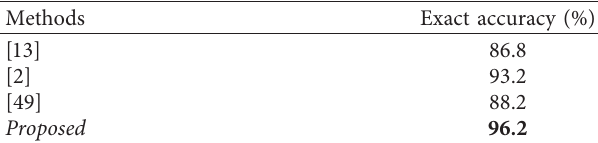
Table 5: Gender classification: performance comparison of our result with the state-of-the-art works on OIU-Adience dataset.